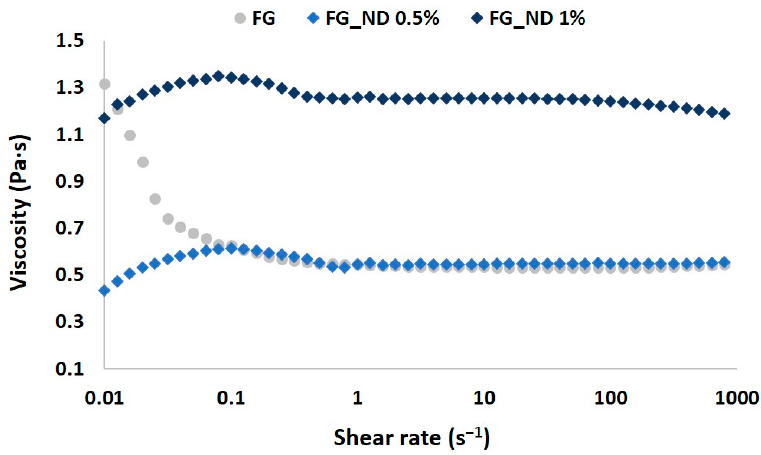
Figure 1. Graphical representation of the influence of precursors’ composition on the viscosity at different shear rates and room temperature.